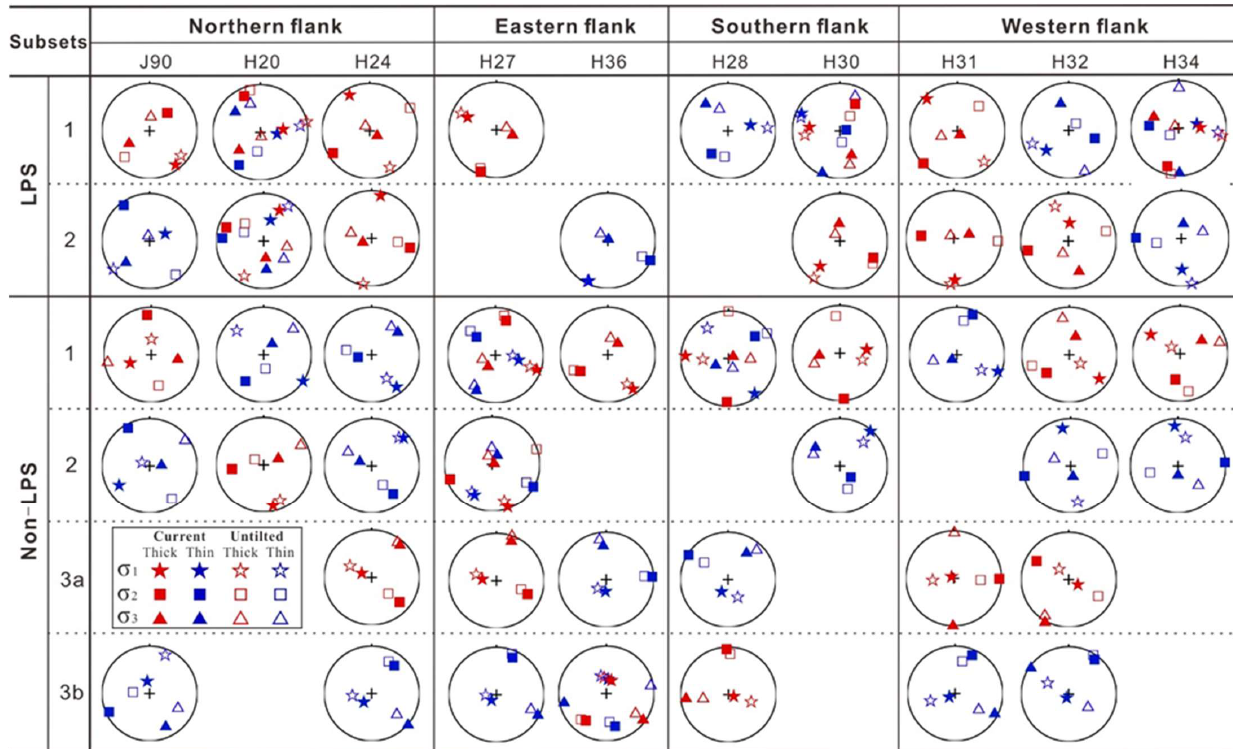
Figure 9. Paleostress results obtained by applying the improved version of Shan et al.'s [30] inversion method to the measured datasets in this study.